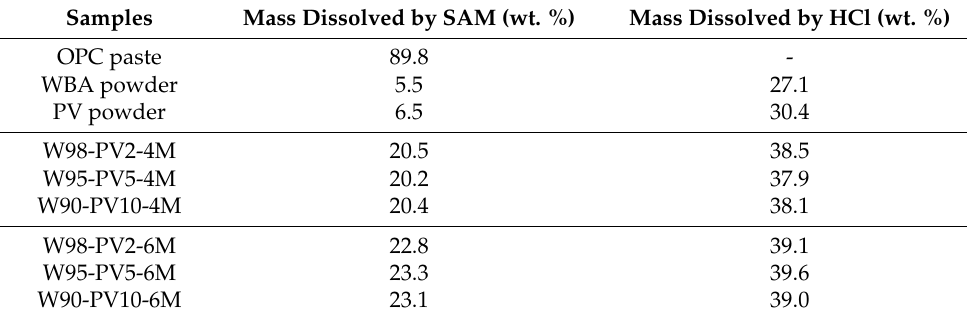
Table 3. Selective chemical extraction results.